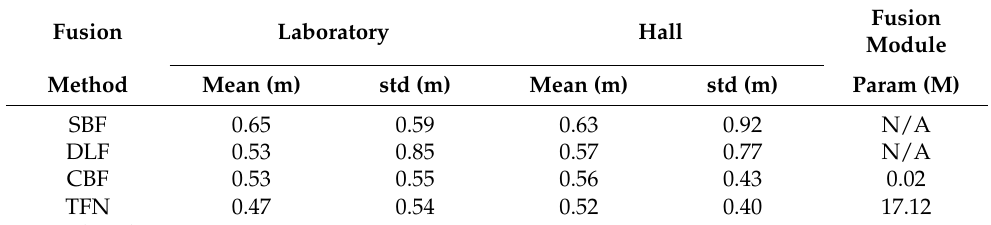
Table 3. Comparison of different fusion methods. For the fusion method using a neural network, the number of parameters of the corresponding fusion module is also given.